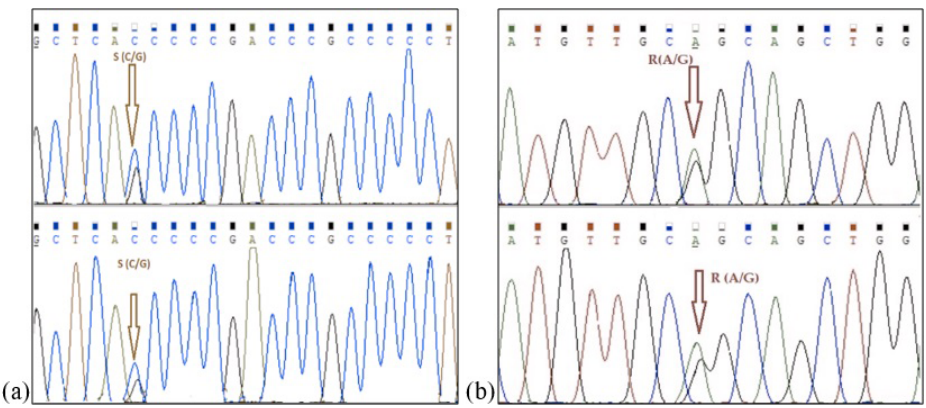
Figure 4. Nucleotide changes from C to G in intron 7 region of DGAT1 gene (point of 155 nucleotide, a ) and from A to G in point of 403 nucleotide Lep gene (point of 111 amino acid, b ). Table 4. The nucleotide variations between the studied sequences and reference sequences of DGAT 1